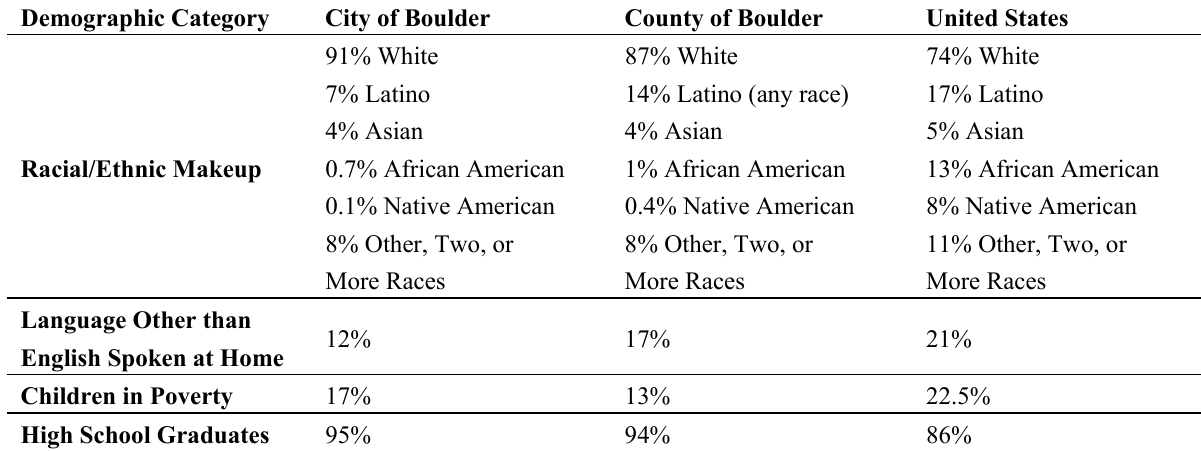
Table 1. Demographic characteristics of Boulder as compared to the United States